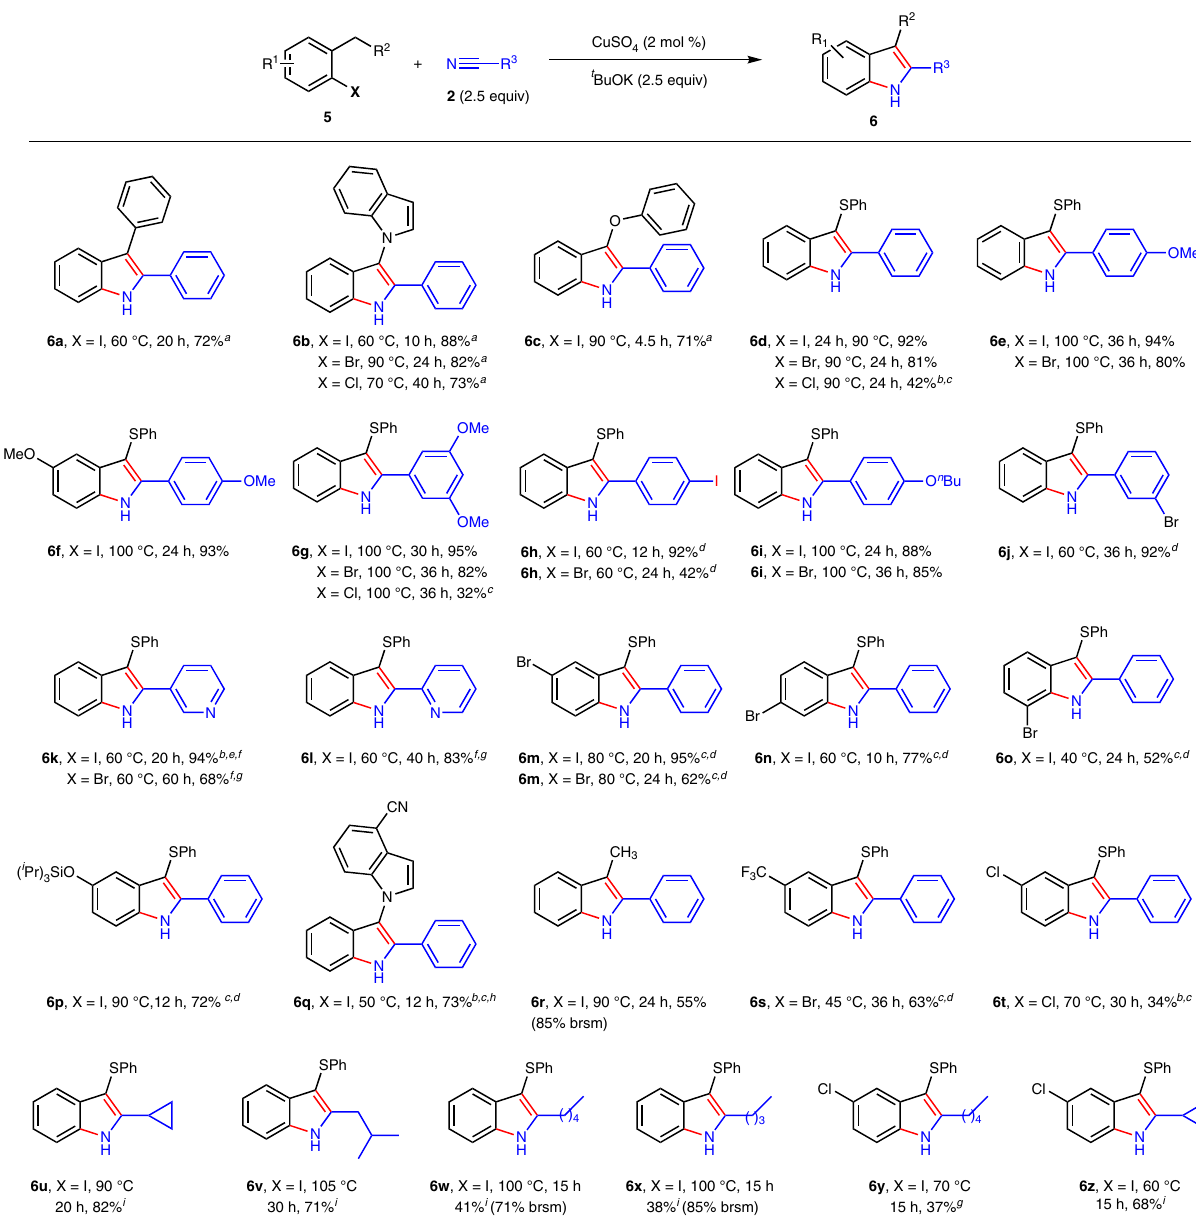
Fig. 5 Scope of C3-functionalized indoles. Reaction conditions: 5 (1 mmol), 2 (2.5 mmol), CuSO 4 (2 mol %), t BuOK (2.5 mmol), dioxane (0.75 mL). a 2 (5 mmol), t BuOK (4 mmol), octane (0.75 mL) instead of dioxane. b 2 (1.5 mL) was used as solvent. c CuSO 4 (10 mol %) was used. d Dioxane (1.5 mL). e 2 (15 mL) was used as solvent. f CuSO 4 (20 mol %) was used. g Dioxane (20 mL). h t BuOK (4 mmol). i t BuOK (4 mmol), no extra solvent. Brsm yield refers